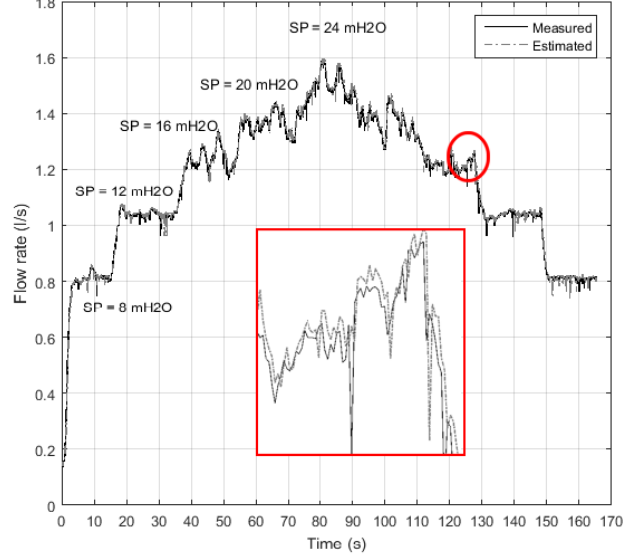
Figure 15. Flow measurement (sensor) and indirect flow estimation during the ANN-NARX test